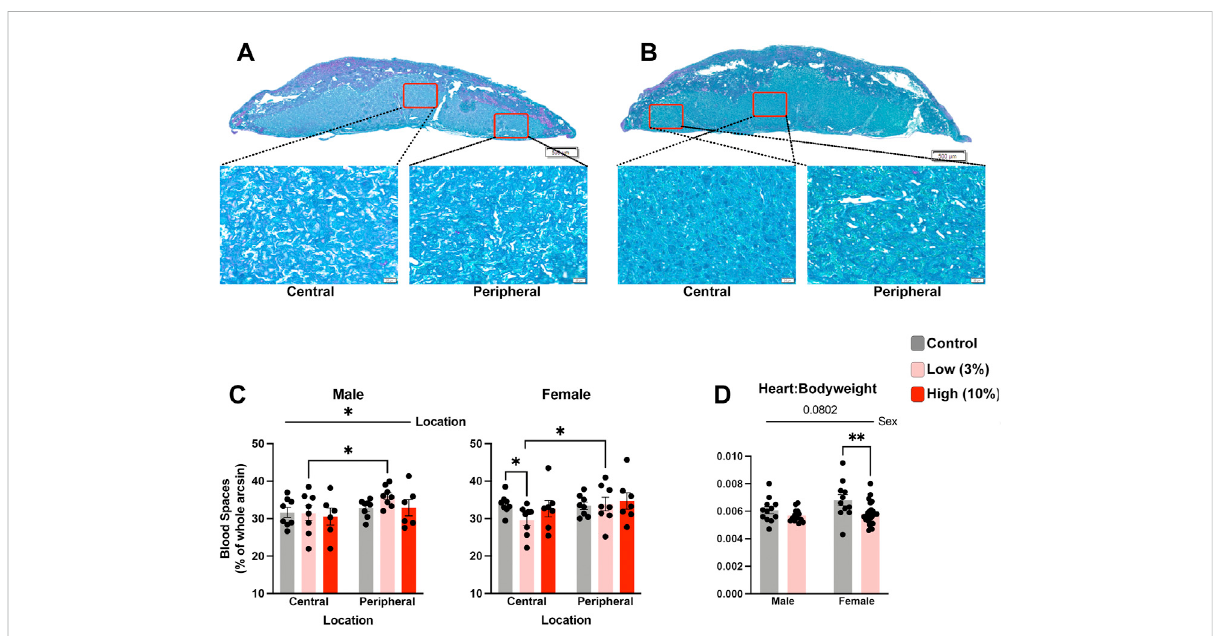
FIGURE 7 Low-concentration paternal alcohol exposures alter placental vascular space. Histological sections comparing central and peripheral vascular spaces between female placentae derived from the offspring of (A) Control and (B) Low-concentration sires. (C) Comparison of placental vascular space between male and female offspring of Control, Low-, and High-concentration sires ( n = fetus, randomly selected from each litter,